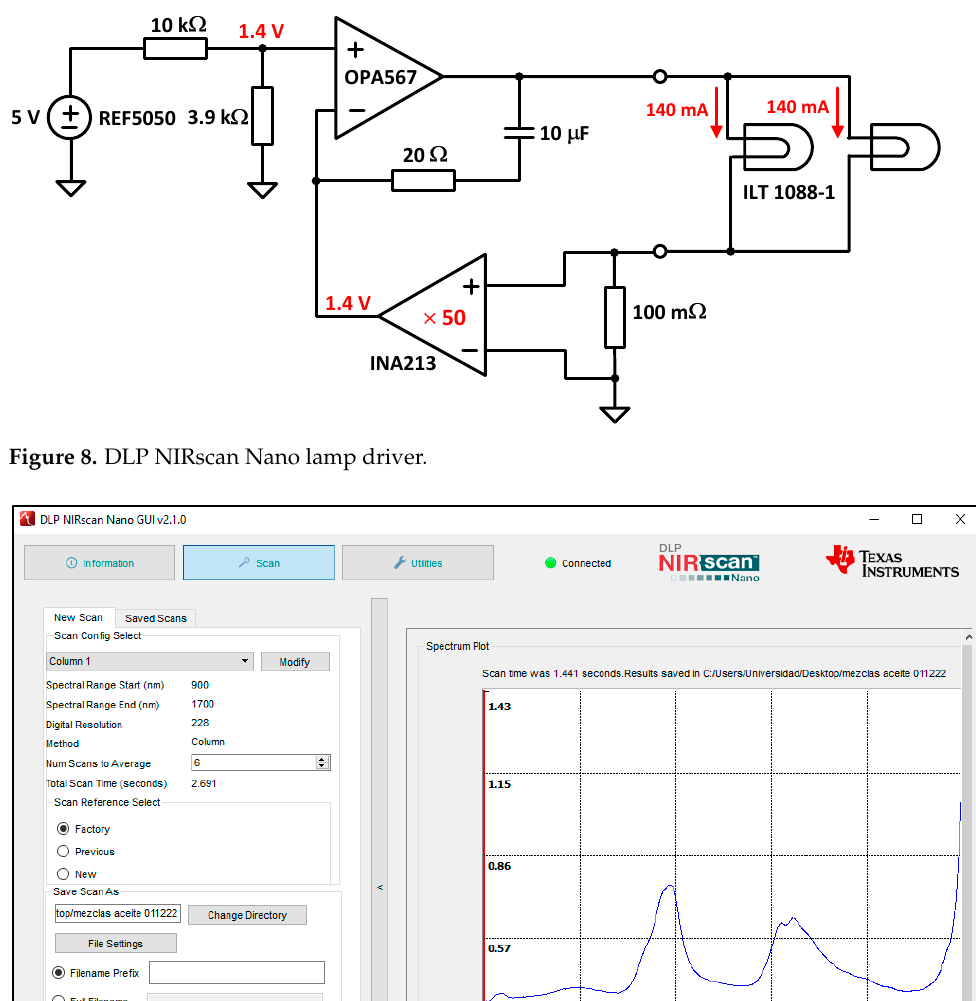
Figure 8. Transimpedance amplifier circuit.